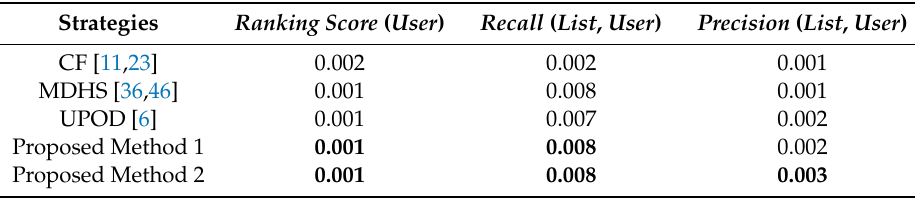
Table 2. Comparison of σ for the proposed methods with existing strategies— MovieLens